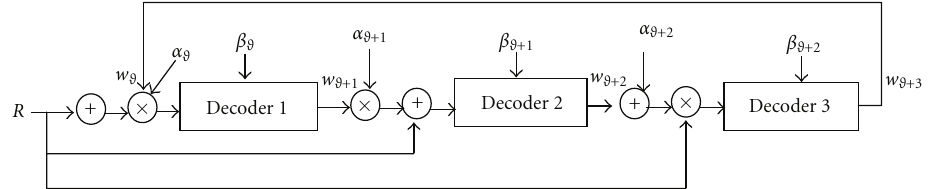
Figure 2: The ( (cid:12) θ/ 3 (cid:13) + 1)th iteration of IGAD1.